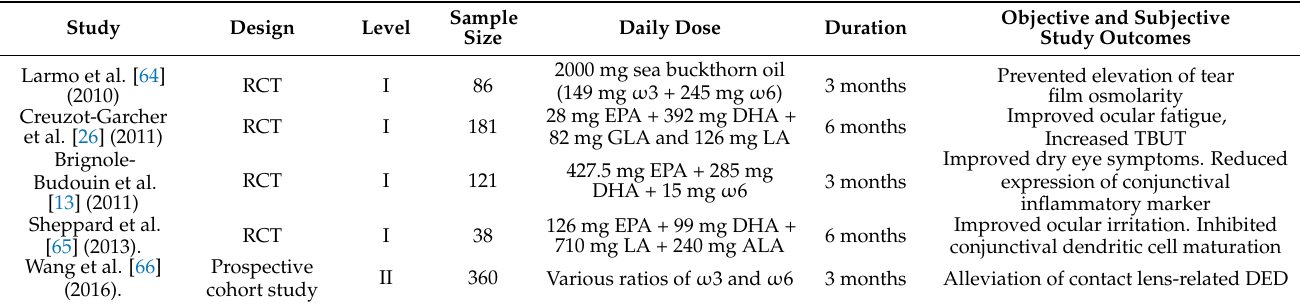
Table 3. Summary of the studies on the efficacy of ω 3 and ω 6 PUFAs on